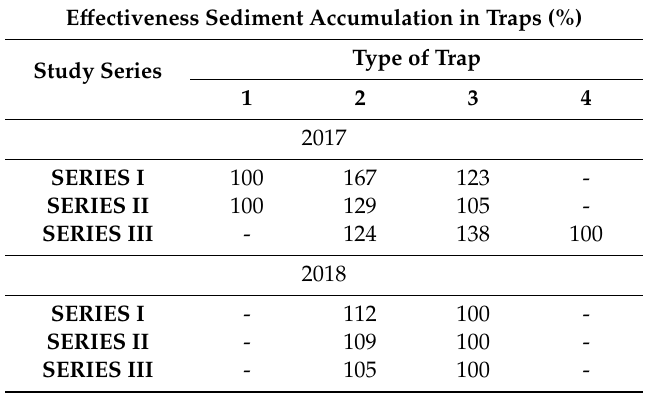
Table 6. Percentage effectiveness of used sedimentary traps systems.